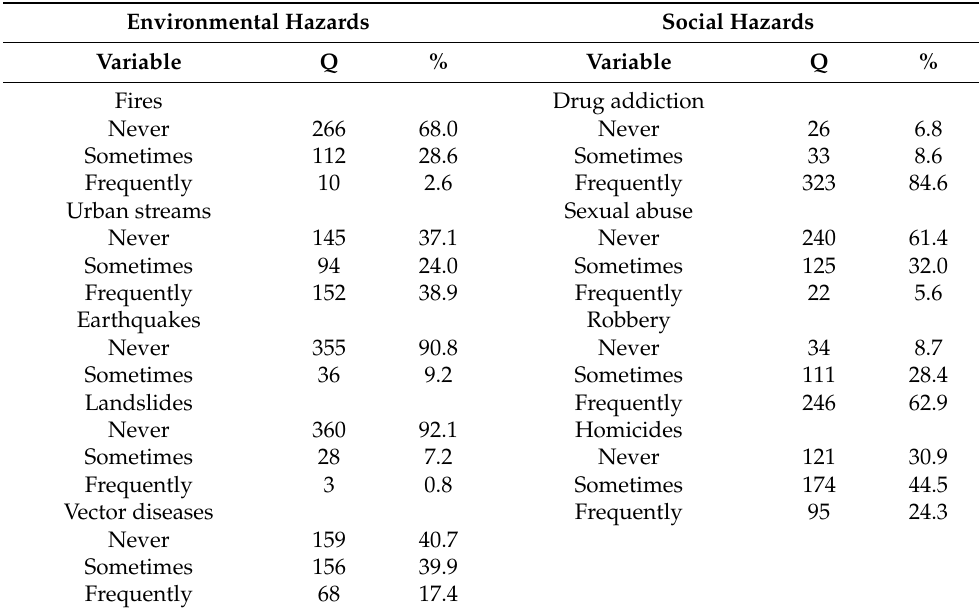
Table 3. Information related to the frequency of hazards in the neighbourhoods (see Supplementary Materials Table S2 for analysis in each